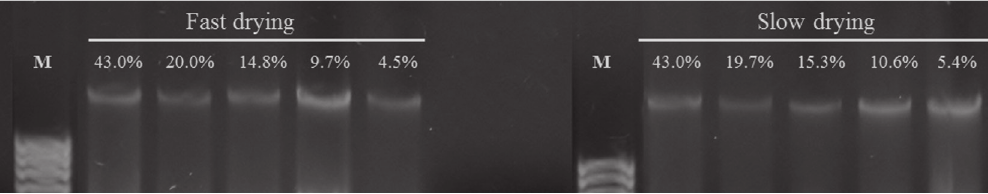
Figure 6 - Agarose gel (1%) of genomic DNA extracted of Campomanesia adamantium seeds subjected to fast drying (silica) and slow drying (room temperature) at different water contents. M: marker 100 bp (molecular